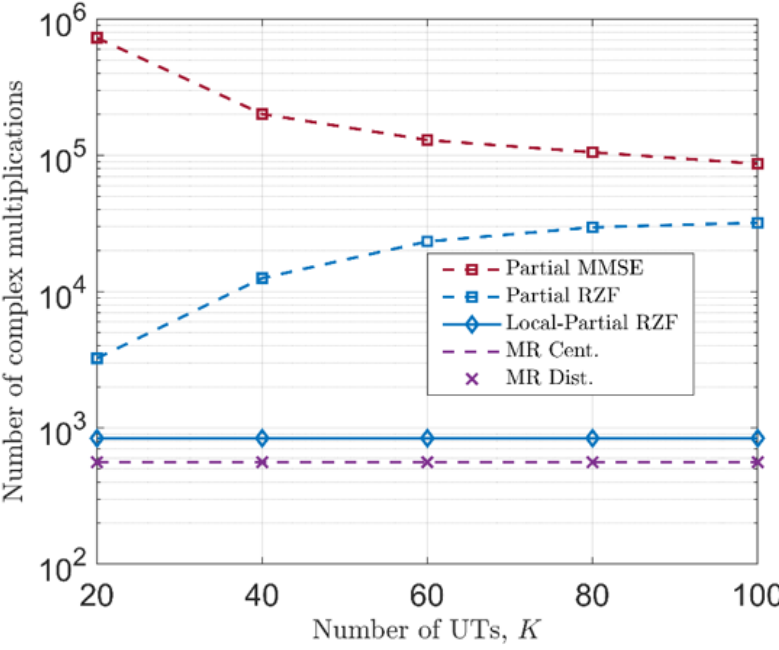
Figure 8. The number of computational complexities as a function of UTs. The total number of ASs in the network L = 100, and each AP is equipped with 4 antennas. We consider τ 0 = 8.